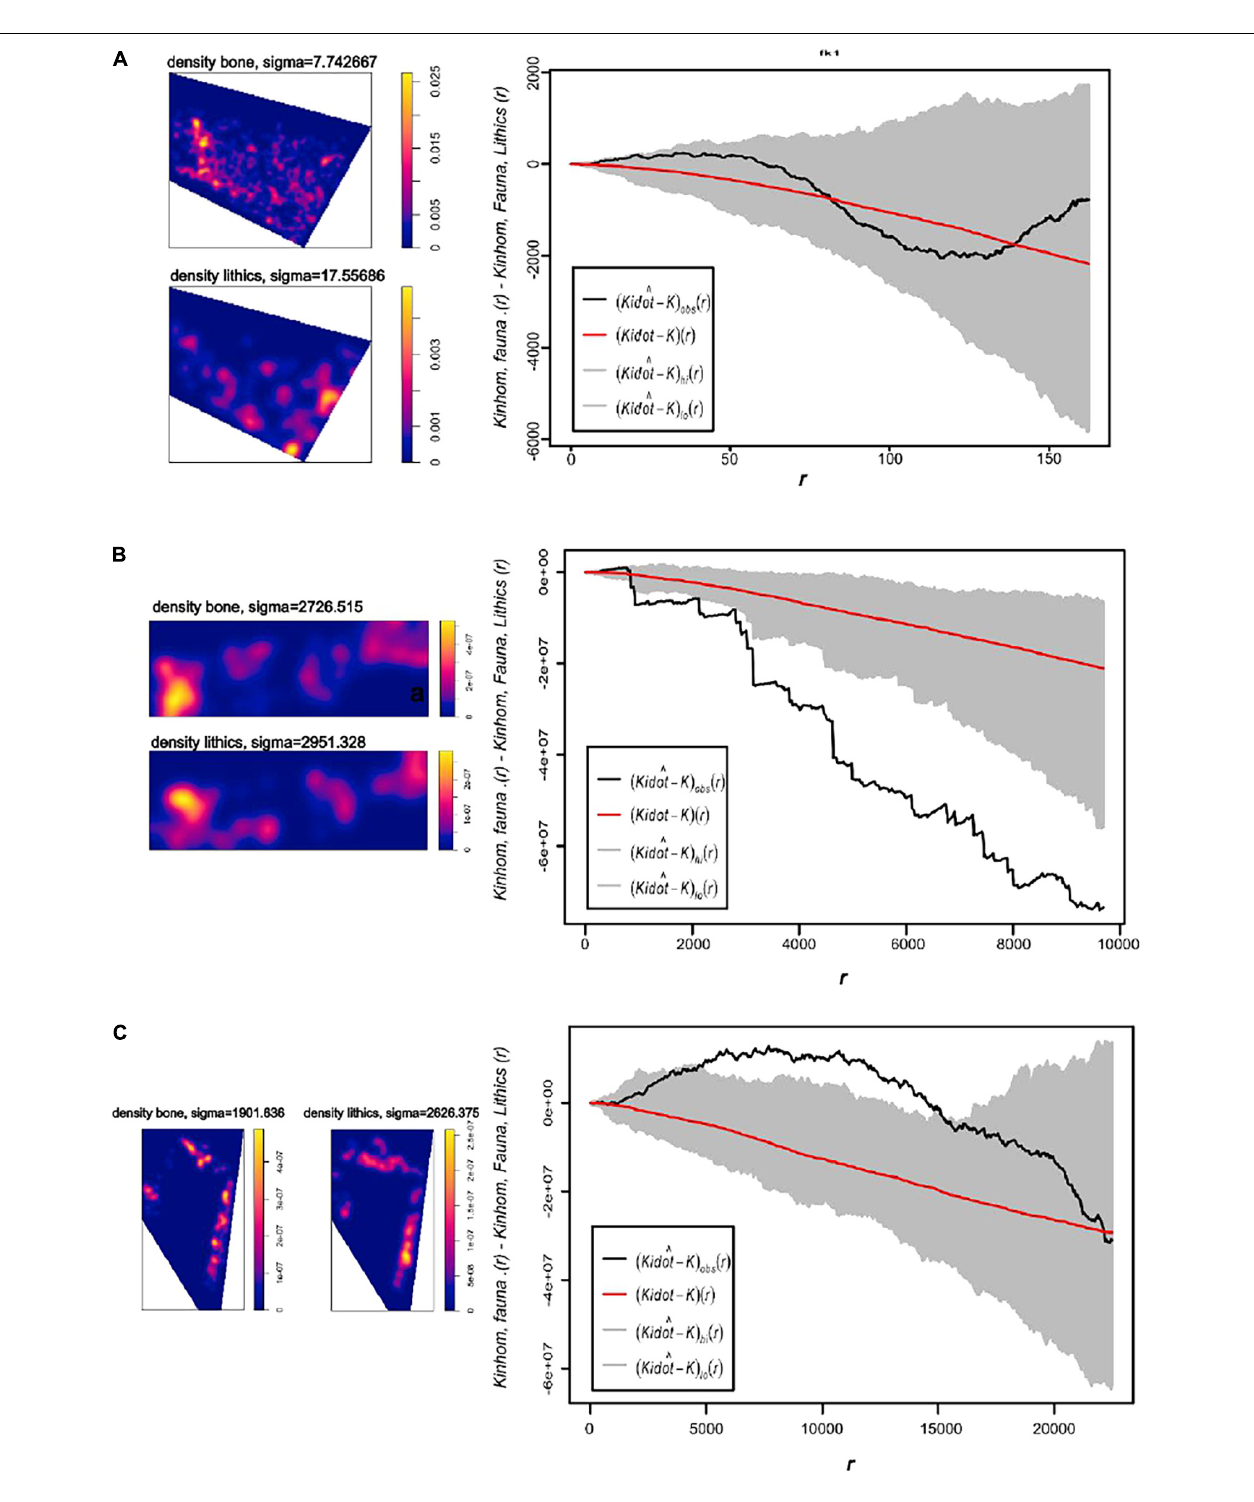
FIGURE 9 | (A) Kernel density maps of the distribution of faunal and lithics remains from trench 2 (left), pointwise envelopes of the homogeneous bivariate Kij(r) function, random labeling cases/controls of lithics and faunal remains from trench 2. (B) Kernel density maps of the distribution of faunal and lithics remains from trench 3 (left), Pointwise envelopes of the homogeneous bivariate Kij(r) function, random labeling cases/controls of lithics and faunal remains from trench 3. (C) Kernel density maps of the distribution of faunal and lithics remains from trench 5 (left), pointwise envelopes of the homogeneous bivariate Kij(r) function, random labeling cases/controls of lithics and faunal remains from trench